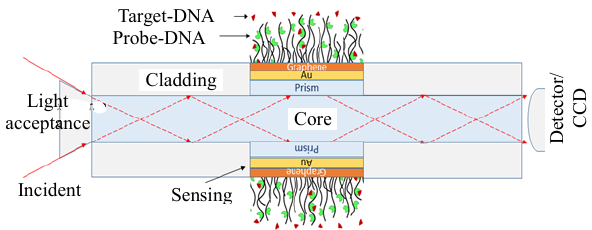
Fig. 1 Structural presentation of 4-layered model for the fiber optic SPR biosensor: prism, Au (50 nm), graphene (0.34 £ nm), and PBS buffer solution which contains probe-DNA (p-DNA:shDNA) and complementary target mutated type (tDNA:mrDNA) or wild-type (tDNA:wtDNA)